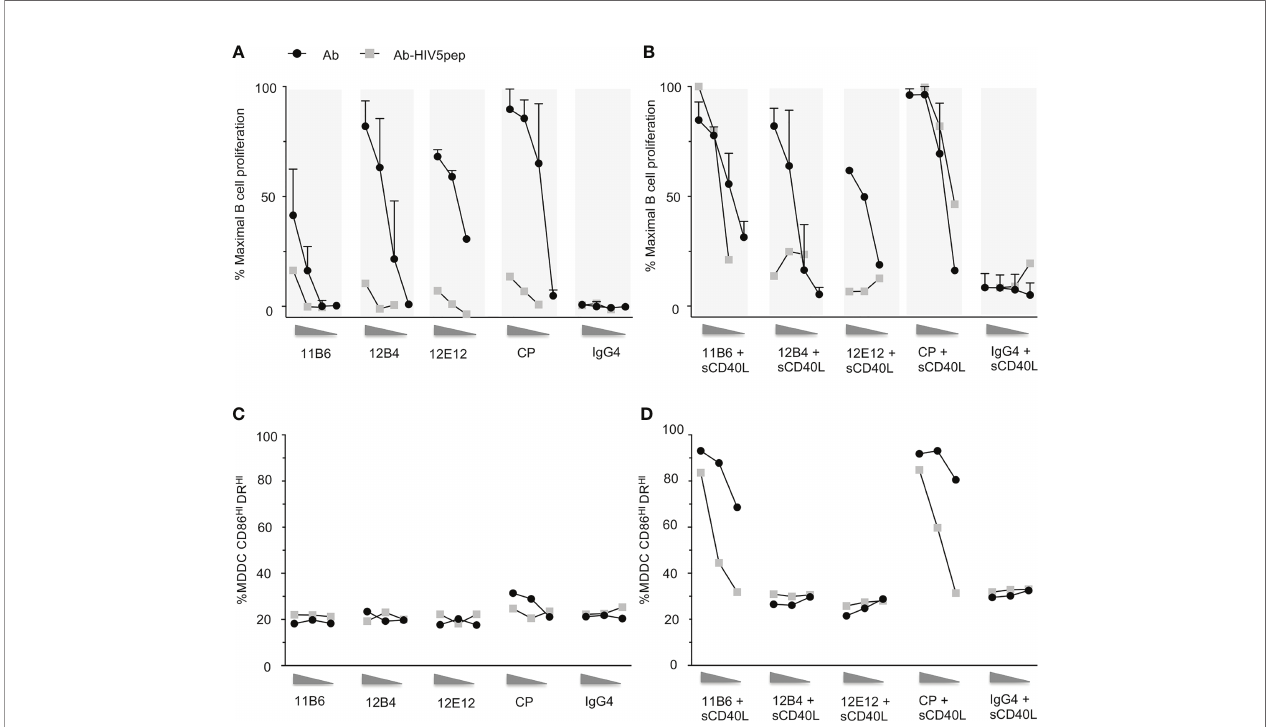
FIGURE 1 | Response of human B cells and human MDDCs to a dose range of anti-CD40 mAbs and matched anti-CD40 HIV5pep antigen fusion proteins incubated with and without a constant low dose of soluble CD40L. (A) shows responses to dose ranges (shown left to right: 10, 1, 0.1 nM for the three point titrations, and 10, 1, 0.1, 0.01 nM for the four point titrations) in six collated independent experiments to the indicated anti-CD40 or control hIgG4 antibodies or of one experiment with the same anti-CD40 hIgG4 or control hIgG4 antibody fused to the HIV5pep antigen. (B) shows response of four collated independent experiments to doses (shown left to right: 10, 1, 0.1 nM for the three point titrations, and 10, 1, 0.1, 0.01 nM for the four point titrations) of the same anti-CD40 or control antibodies and one independent experiment with matching HIV5pep fusion proteins in the presence of 100 ng/ml (6 nM) monomeric soluble human CD40L. The data were normalized to the maximum B cell proliferation observed in each experiment. (C, D) show DC activation responses to a dose range (shown left to right: 10, 1, 0.1 nM) of each indicated anti-CD40 hIgG4 mAb and matching anti-CD40-HIV5pep fusion protein antibodies in the absence (C) or presence of 100 ng/ ml (6 nM) soluble human CD40L (D) . The percentage of cells with high expression of CD86 and DR determined by fl ow cytometry is shown. Data are from a single representative experiment. We have previously shown analogous data for the indicated non-fusion antibodies with or without sCD40L (13), and these data are included for reference. The control hIgG4 antibody we used does not bind to human monocytes, B cells, or MDDCs